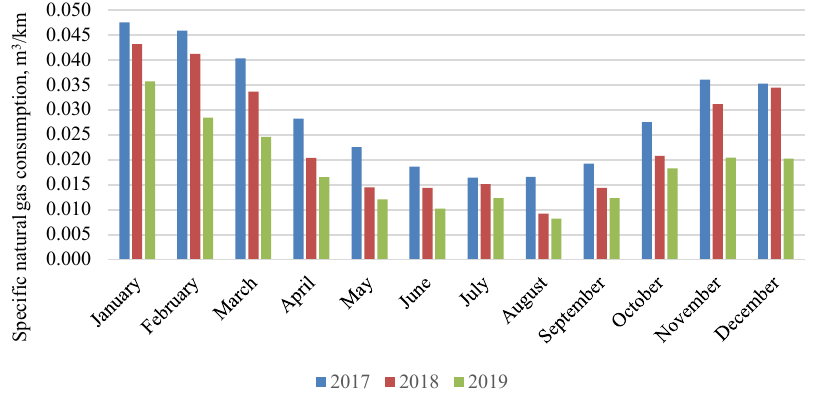
Fig. 1. Specific natural gas consumption over three years .